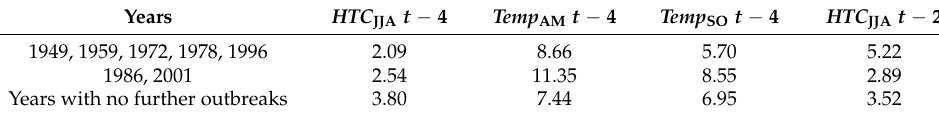
Figure 3. Cluster analysis of weather conditions in the pre-outbreak years. The analysis involves the predictors used in model B (Table 1). Table 2. Average values of weather characteristics influencing pine looper outbreaks ( HTC is dimen- sionless, ◦ C shows temperature). Weather characteristic symbols as in Table 1 HTC S ( t − 4) are not shown here (see Section